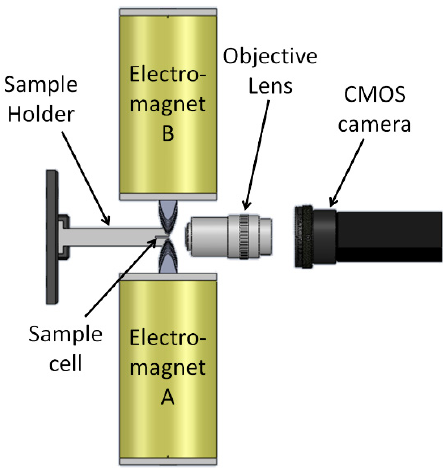
Figure 3. Experimental setup of two electromagnets with parabolic pole-tips that are positioned opposite each other. The sample cell is positioned between the poles using a sample holder and an XYZ translational stage. The movement of the magnetic beads in the cell is imaged to the back plane of an objective lens and visualized using a CMOS camera.